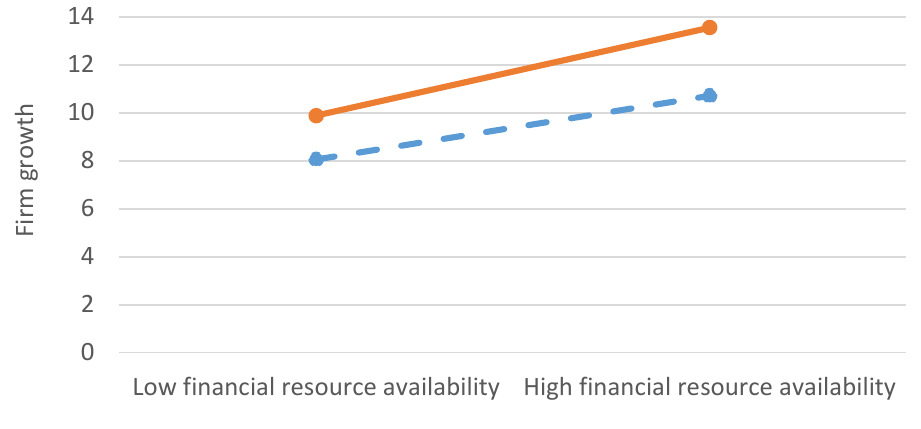
Figure 1. The joint effect of financial resource availability and financial literacy on firm